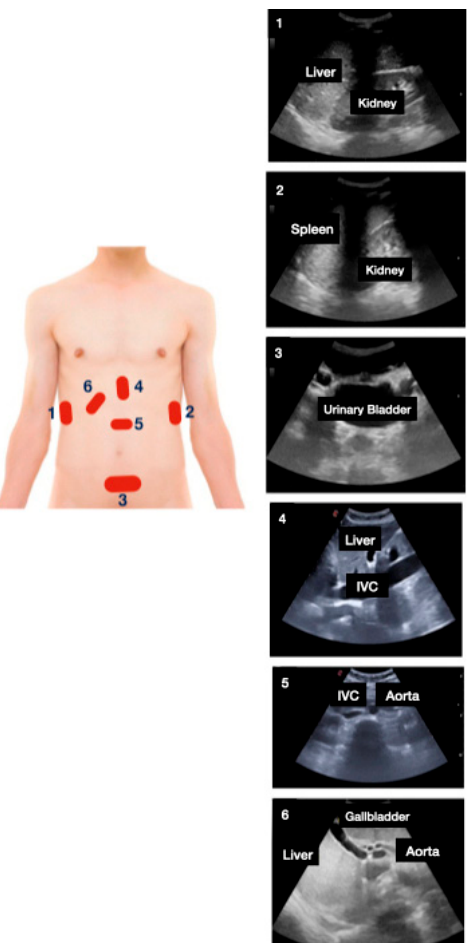
Figure 3. Abdominal FAST — Focused Assessment with Sonography in Trauma —protocol views: (1) peri- hepatic, (2) perisplenic, (3) pelvic, (4) subxiphoid longitudinal view, and (5) subxiphoid transverse view (IVC: inferior vena cava). Followed by hepatic and biliary protocol views: (6) right sub- costal